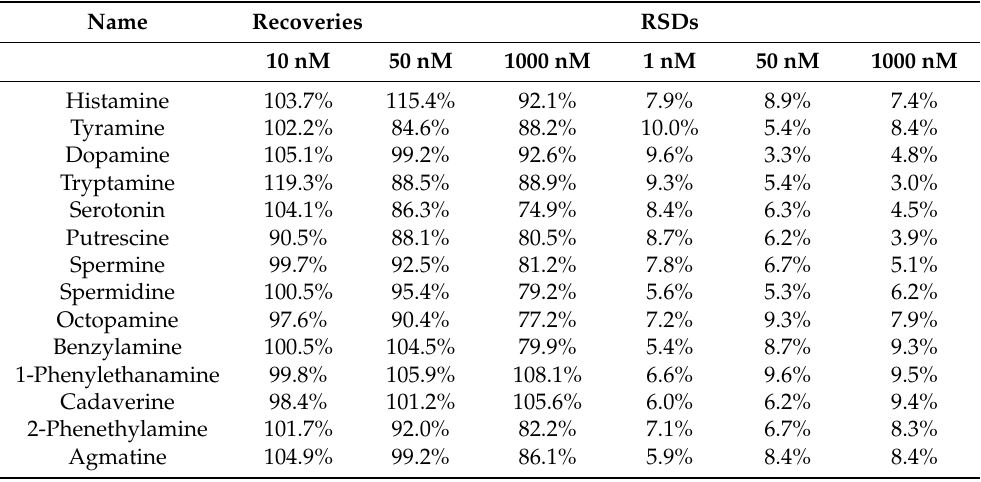
Table 3. Recoveries and RSDs of 14 BA derivatives, including extraction processing, derivatization, and LC–MS analysis.